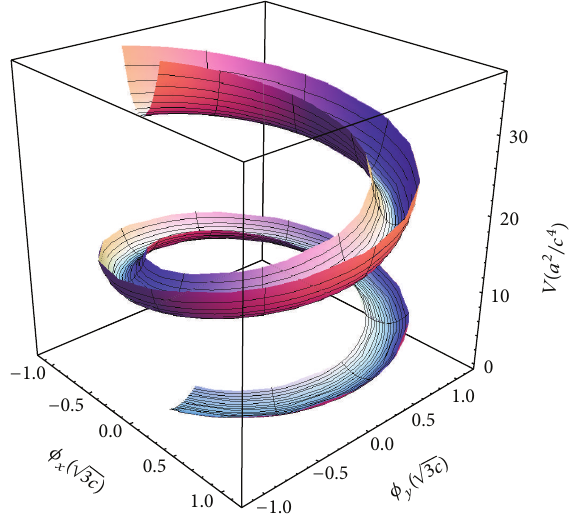
Figure 3: The helicoid structure of potential (43) scaled by 𝑎 2 /𝑐 4 . In the graph, the parameter Λ is tuned so that 𝑟 0 = 𝑟 1 . The complex field Φ has been rescaled by √3𝑐 , and the scale of field norm at local valley is determined by the parameter 𝑐 instead of the Planck